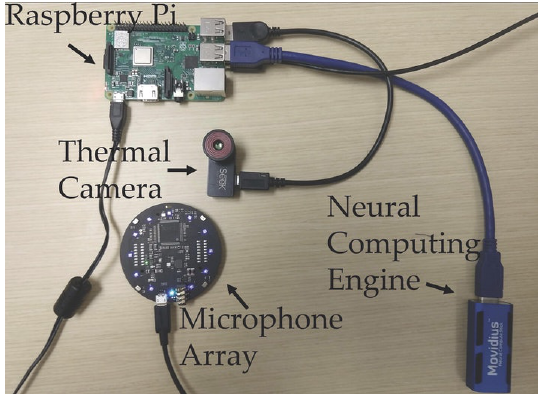
Figure 5. The FluSense device houses these components